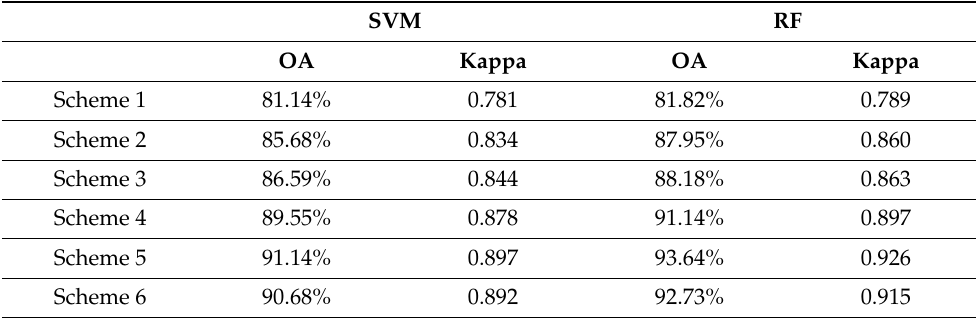
Table 7. Overall accuracy (OA) and kappa coefficient of each